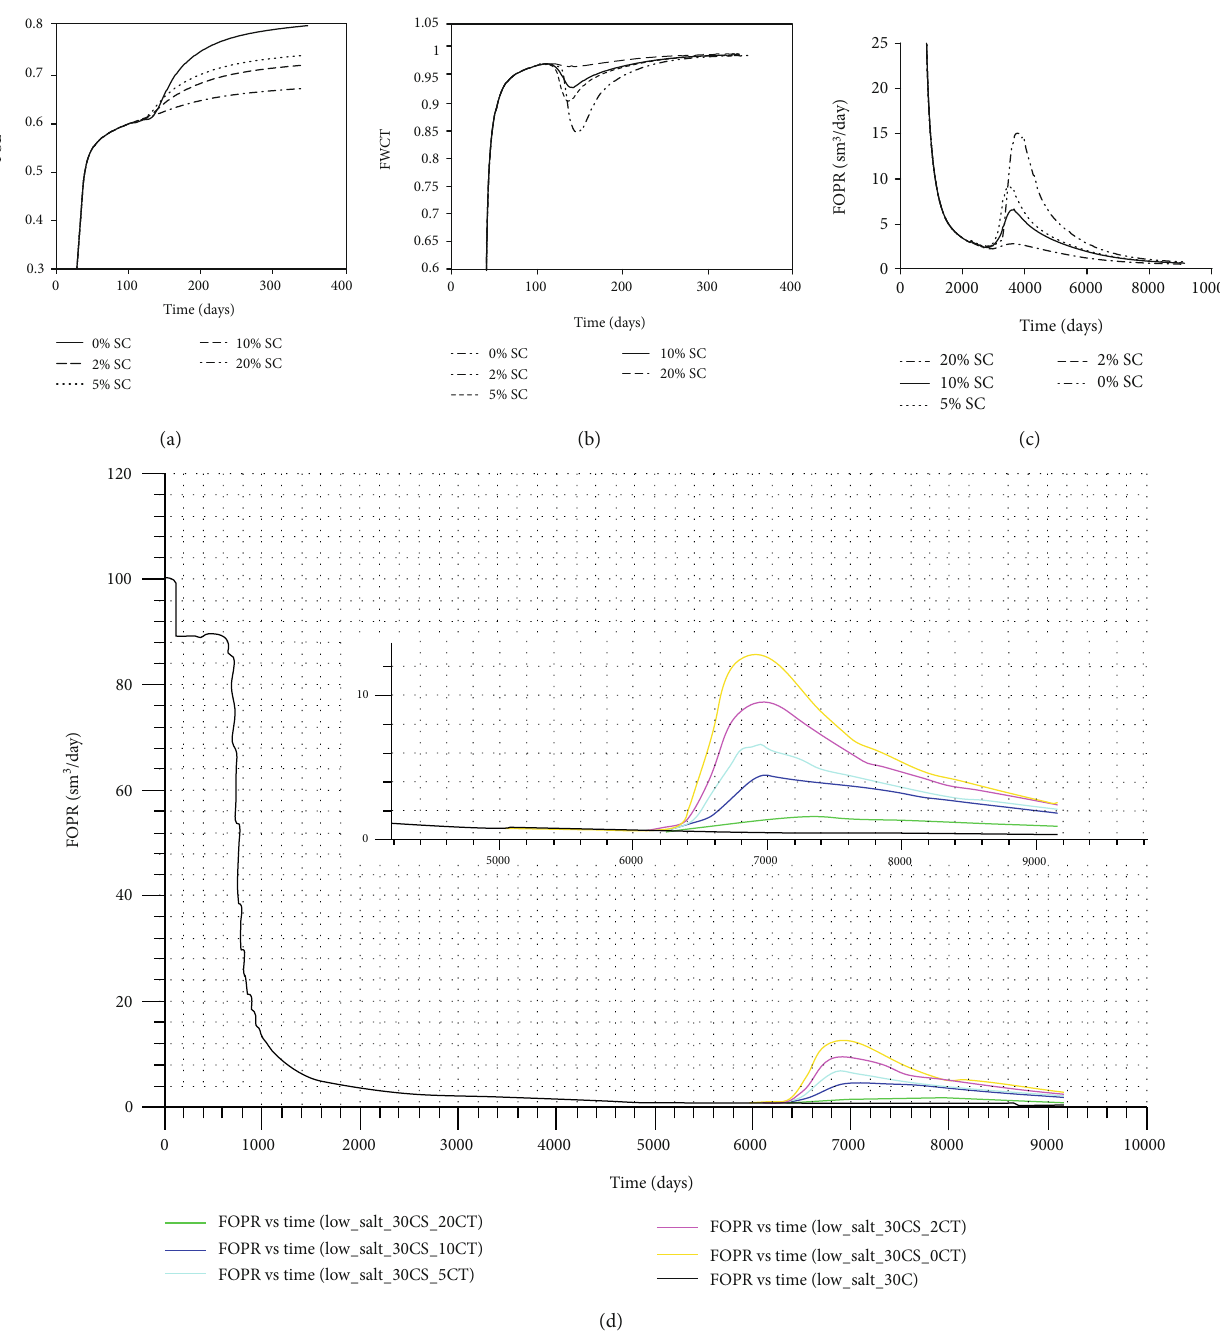
Figure 3: (a) Oil recovery. (b) Water cut. (c) Oil production rate. (d) Field oil production rate plot for Cases 1 and